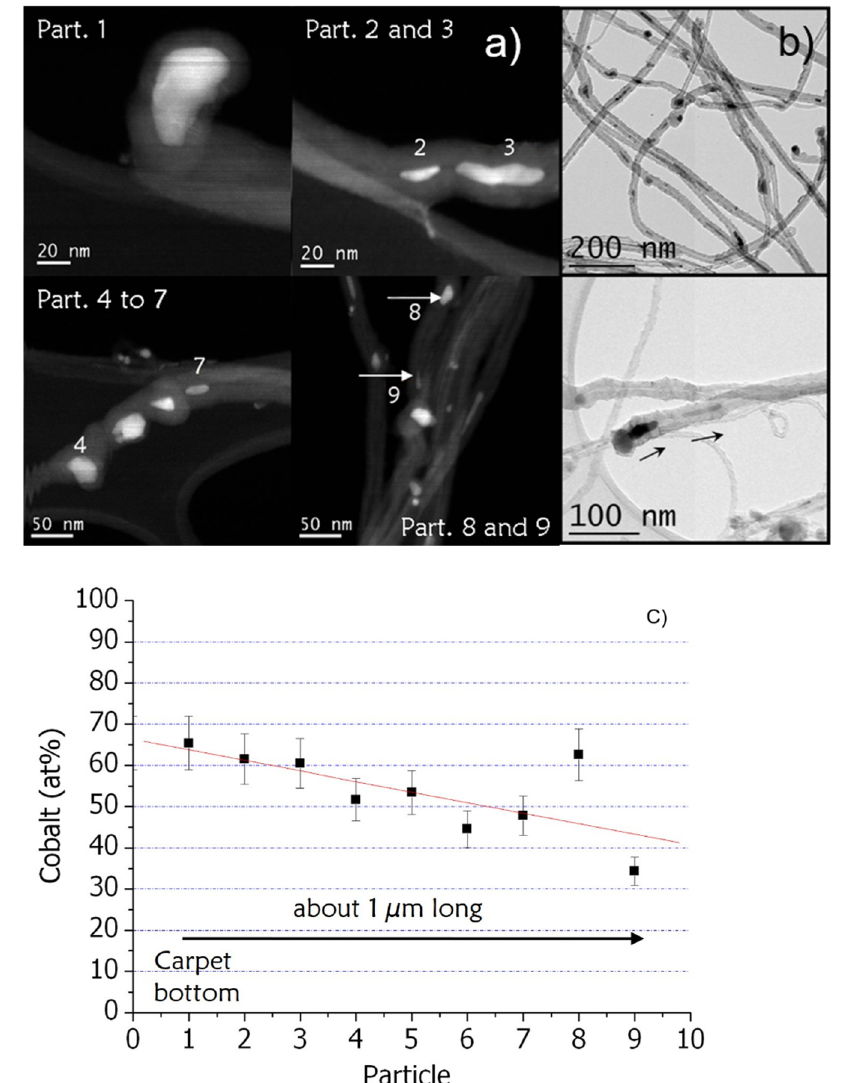
Figure 5. ( a ) annular dark field STEM images of analyzed particles by EELS along the bottom part of one CNT. ( b ) TEM images of CNTs obtained in the sequenced synthesis, ( c ) evolution of the cobalt content as compared to the iron one as a function of the analyzed particles (Co/(Fe + Co)). The first particle corresponds to the catalyst particle located at the base (root) of the CNT and the last particle corresponding to the upper particle identified.